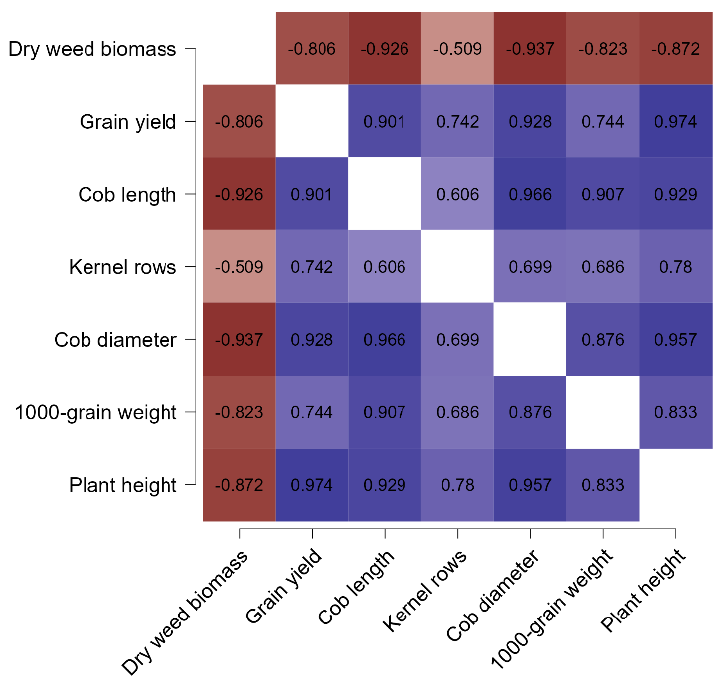
Figure 6. Correlation analysis of the estimated parameters.